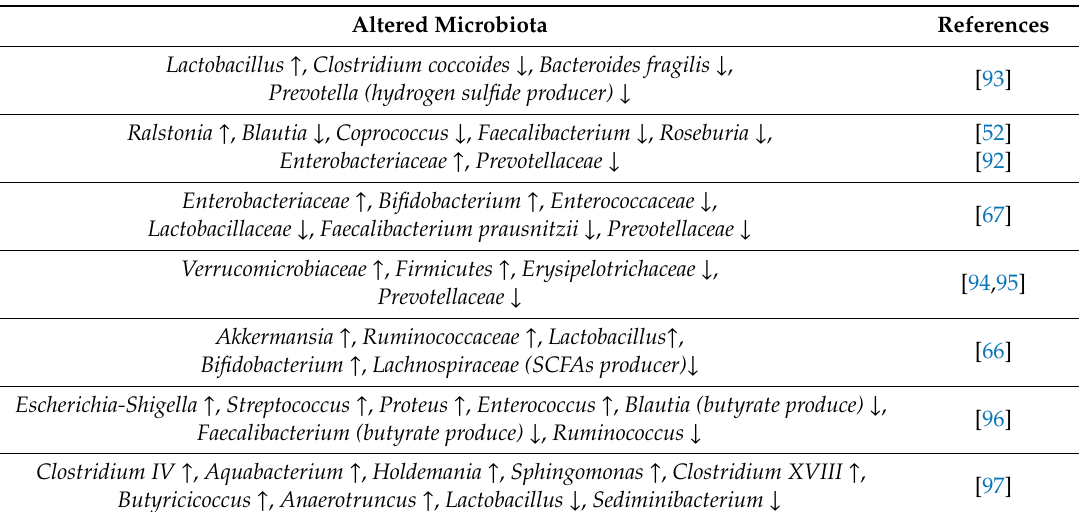
Table 1. Altered gut microbiota compositions in PD patients [74] (reused with permission, license number: 4637580890170, Elsevier and Copyright Clearance